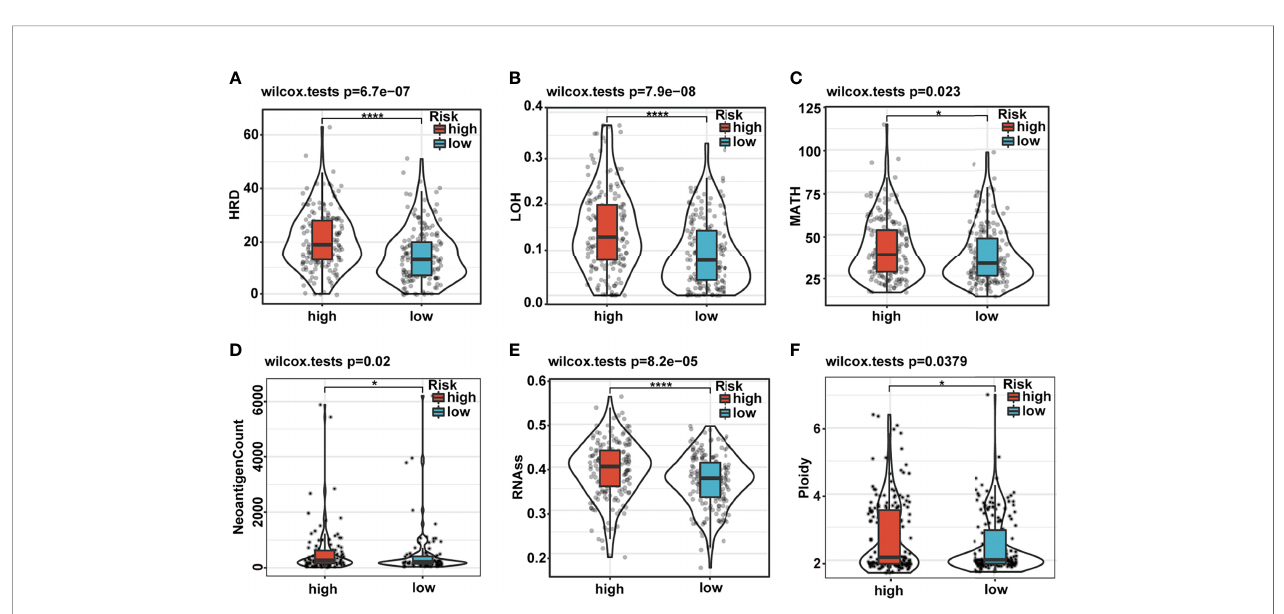
FIGURE 7 | Differences in cancer marker scores between high- and low-risk groups. (A – F) The differences in HRD, LOH, MATH, neoantigen count, RNAss, and ploidy, between the low- and high-risk groups, are displayed in boxplots. HRD, homologous recombination de fi ciency; LOH, loss of heterozygosity; MATH, Mutant- Allele Tumor